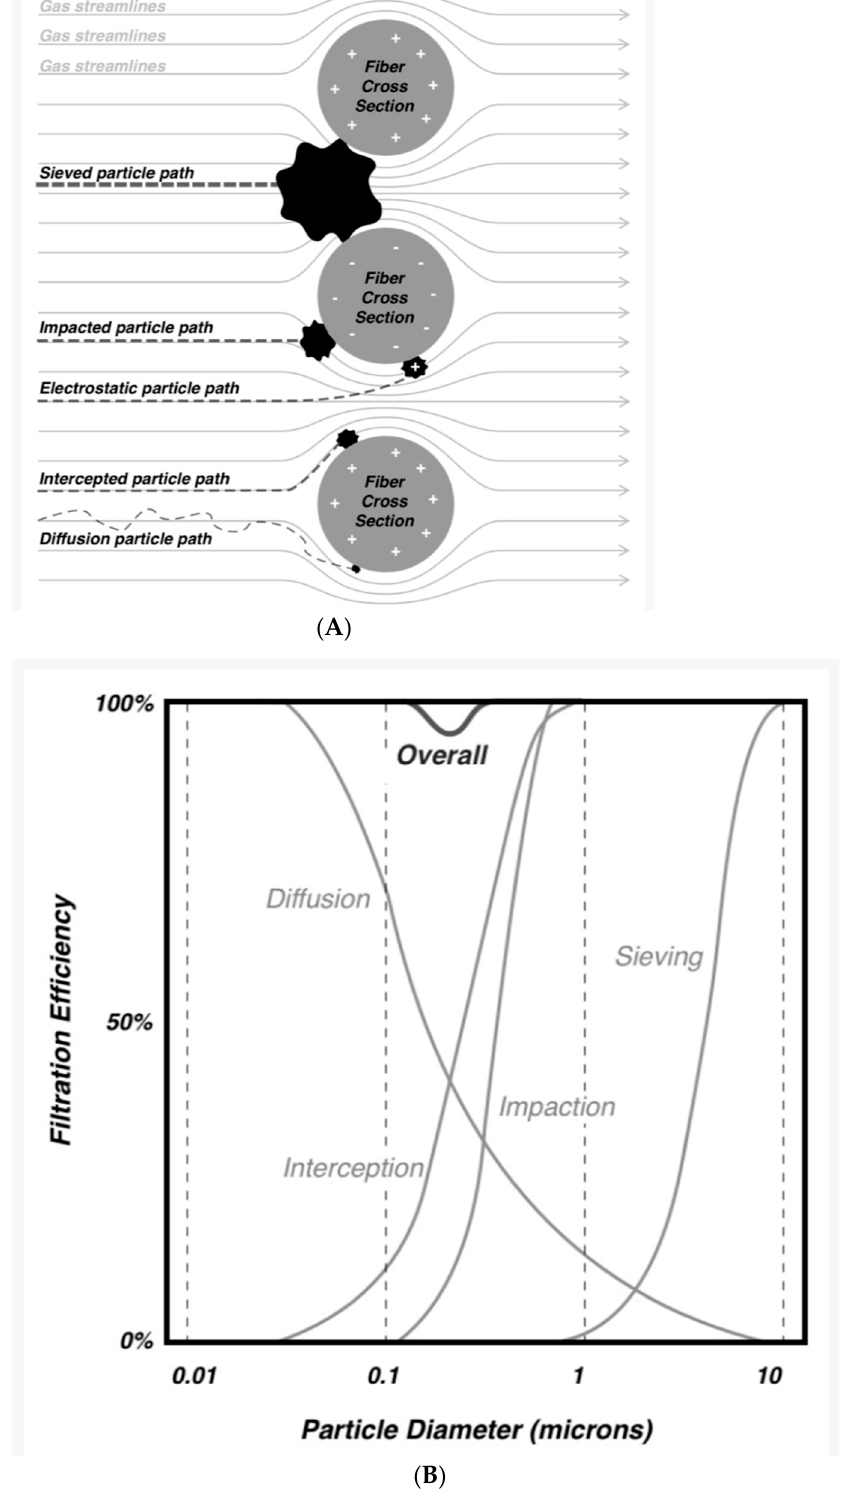
Figure 4. A. Various phenomena involved in the fi ltration process using a fi brous membrane; B. (virus) particle size vs. fi ltration e ffi ciency (from [16]). ( B ) (virus) particle size vs. filtration efficiency (from